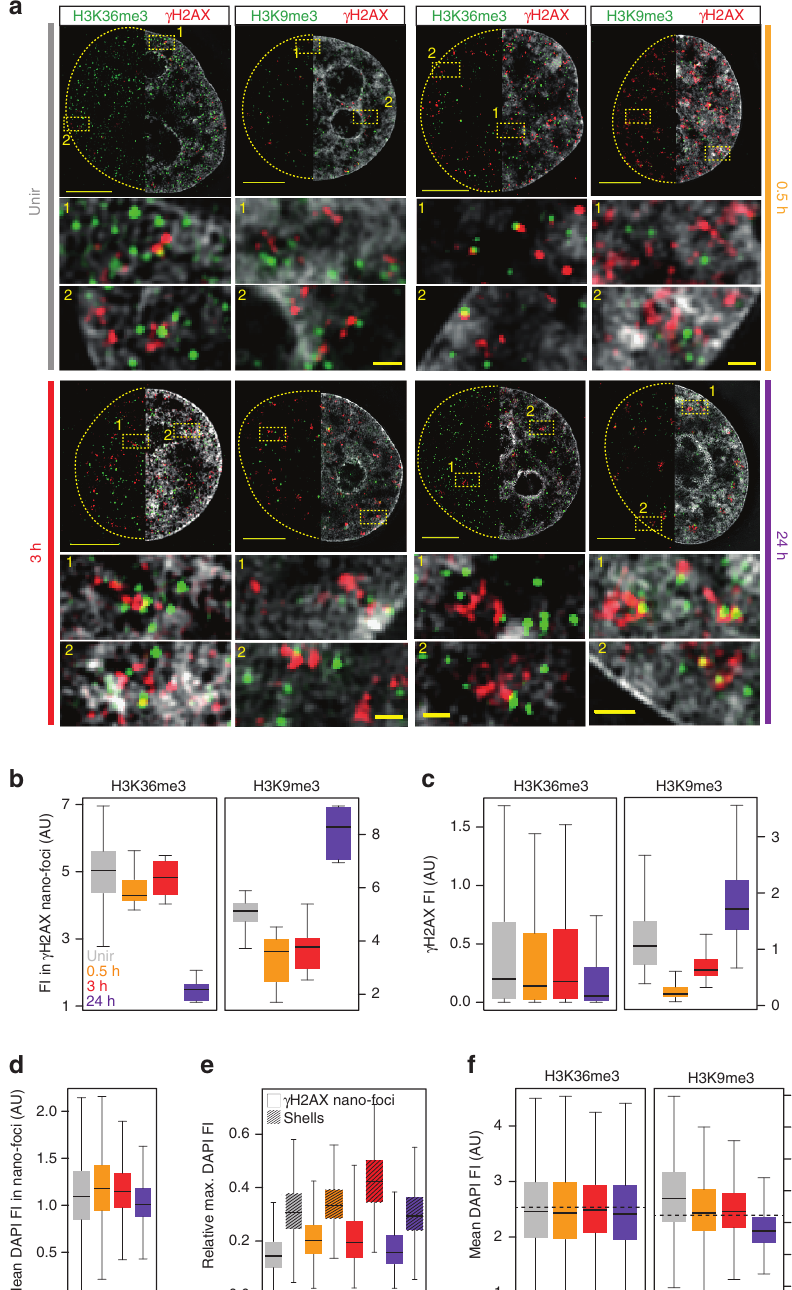
Figure 4 | 3D-SIM chromatin composition analysis of c H2AX nano-foci before and during DDR. ( a ) Exemplary 3D-SIM images of g H2AX (red) and H3K9me3/H3K36me3 (green) co-immunostaining before and after IR. Top panels: mid-nuclear sections showing g H2AX and histone marks with (right half) or without (left half) DAPI counterstaining. The dashed lines depict the nuclear contour. Bottom panels: magnification of the yellow dashed boxes with corresponding reference number. Scale bars, 5 m m and 500nm for main micrographs and magnified regions, respectively. ( b ) Quantification of the H3K36me3 and H3K9me3 fluorescence intensities measured in g H2AX nano-foci volumes. Kruskal–Wallis w 2 ¼ 19.875, df ¼ 3, P ¼ 1.802 (cid:3) 10 (cid:2) 4 and Kruskal–Wallis w 2 ¼ 24,451, df ¼ 3, P ¼ 2.011 (cid:3) 10 (cid:2) 5 . ( c ) Quantification of the g H2AX fluorescence intensity in H3K36me3- (Kruskal–Wallis w 2 ¼ 261,960, df ¼ 191,020, P o 2.2 (cid:3) 10 (cid:2) 16 ) and H3K9me3- (Kruskal–Wallis w 2 ¼ 246,300, df ¼ 232,750, P o 2.2 (cid:3) 10 (cid:2) 16 ) decorated chromatin. ( d ) Mean DAPI intensity in g H2AX nano-foci. Kruskal–Wallis w 2 ¼ 247,910, df ¼ 245,320, P ¼ 1.129 (cid:3) 10 (cid:2) 4 . ( e ) Quantification of maximum DAPI intensity in the volume